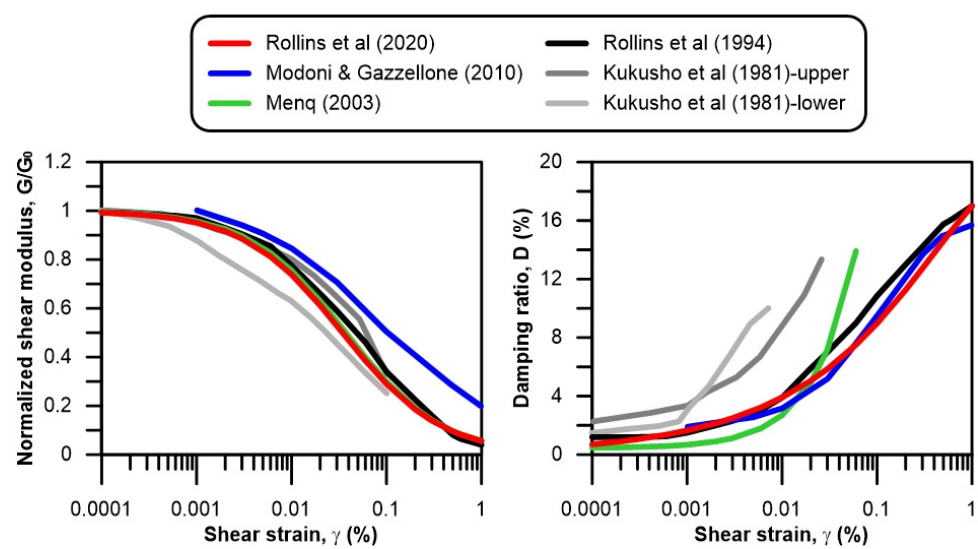
Figure 17. Normalized shear modulus and damping ratio curves adopted for the shallowest 15 m of the soil column. Rollins et al. (2020) [96]; Modoni & Gazellone (2010) [95]; Menq (2003) [94]; Rollins et al. (1994) [93]; Kukusho et al. (1981) [92].